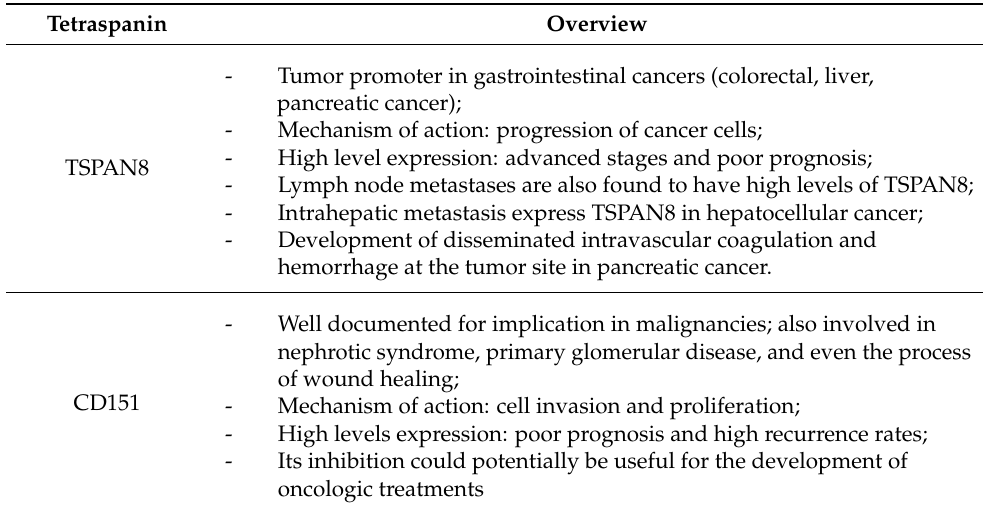
Table 2. Summary of tumor progression-promoting